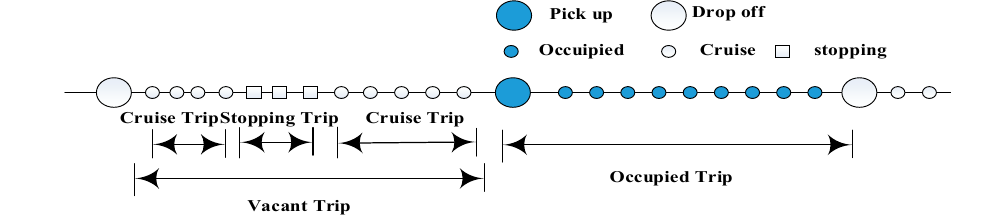
Figure 1. An example of a taxi trajectory and its trips.